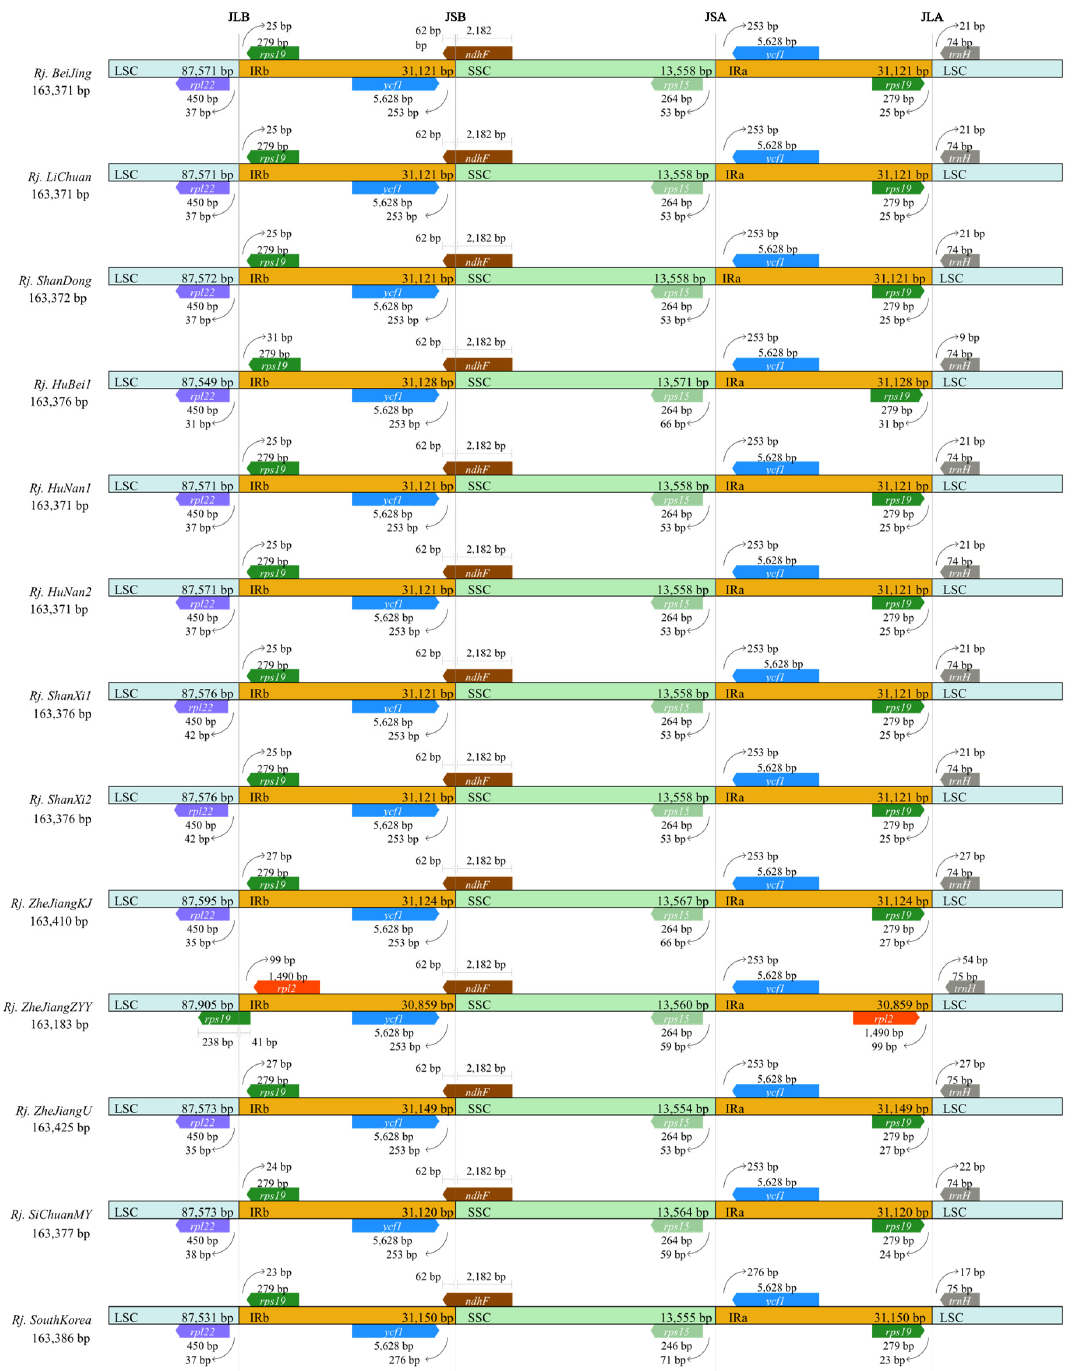
Figure 2. Comparison of the borders of large single-copy (LSC), small single-copy (SSC), and inverted repeat (IR) regions among the 13 R. japonica chloroplast genomes. Genes are denoted by colored boxes, and the gaps between the genes and boundaries are proportional to the distances in bps.